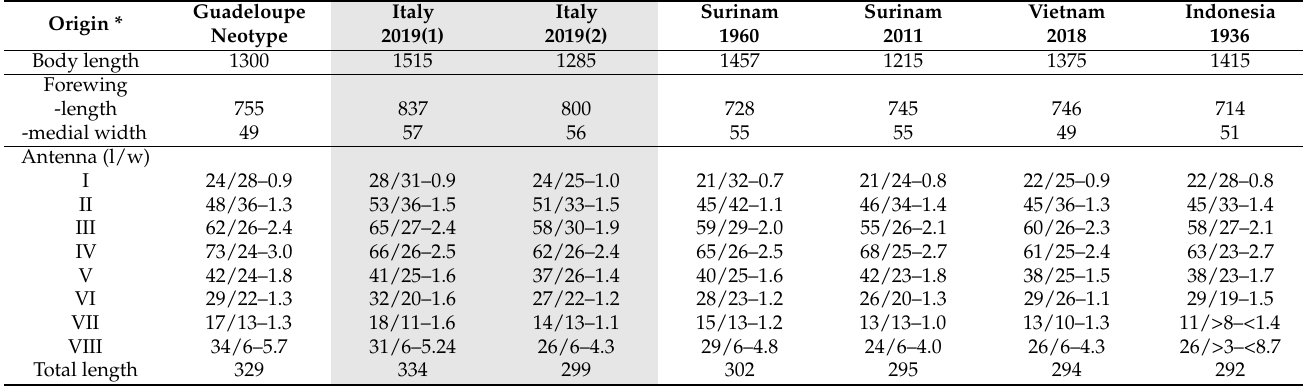
Table 3. Body length, forewing length, and width and length/width ratio of antennal segments in µ m of single females of Selenothips rubrocinctus .